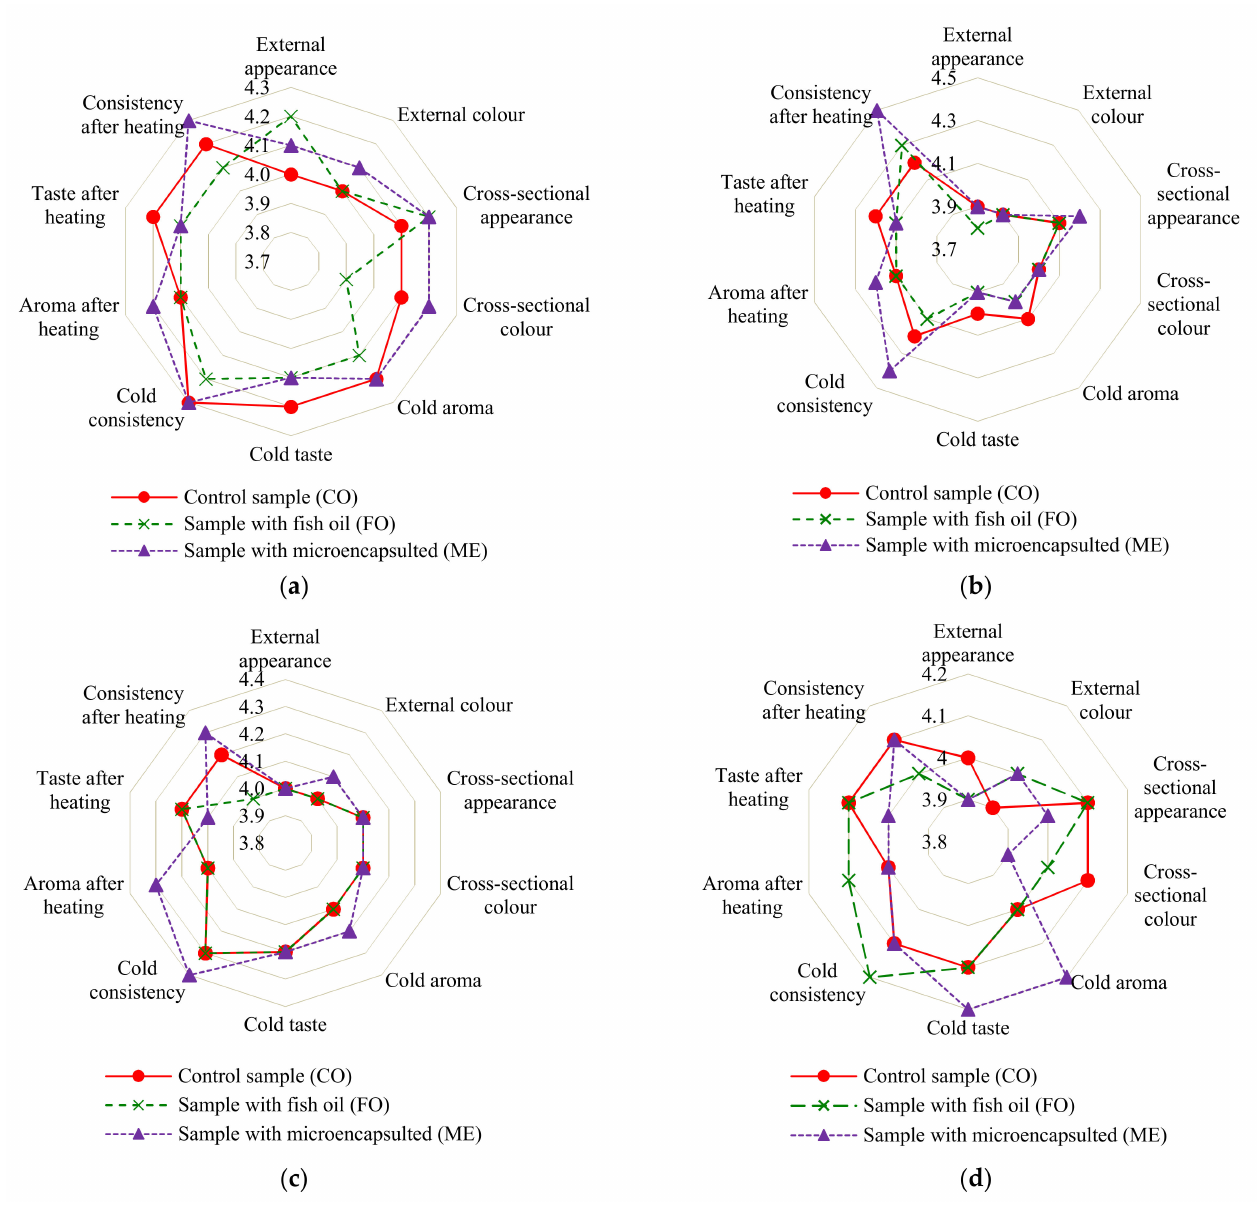
Figure 8. The scores of the trained panel for the intensity of the sensory characteristics of the model systems of chicken sausages: vacuum packed ( a ) the 1st and ( b ) 21st day of storage; modified atmosphere packed ( c ) the 1st and ( d ) 21st day of storage ( n =